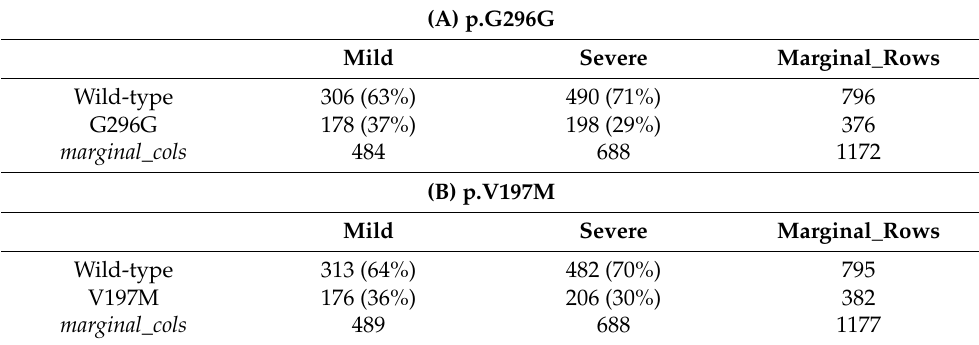
Table 1. Contingency tables of TMPRSS2 mutations in the two categories of